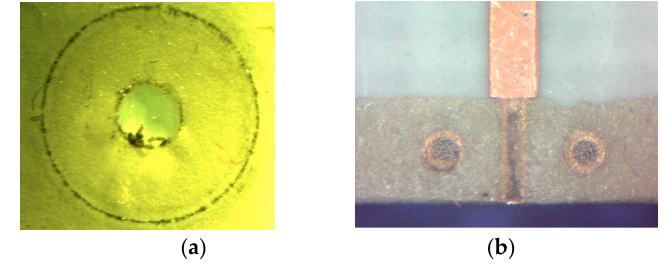
Figure 27. ACP with embedded spheres. ( a ) agglomerated after >100 contact cycles between sexless connectors ( b ) microstrip-to-microstrip transition.